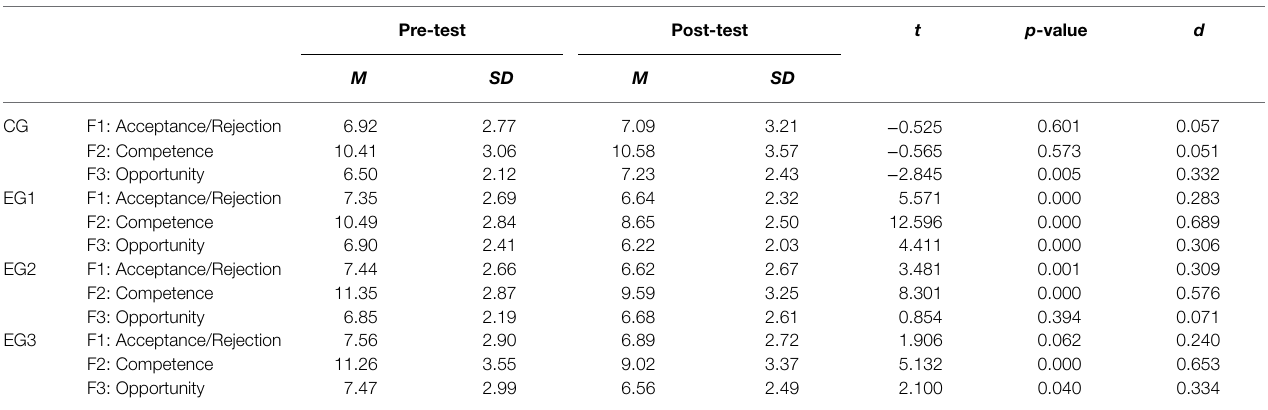
TABLE 4 | Intra-group analysis.